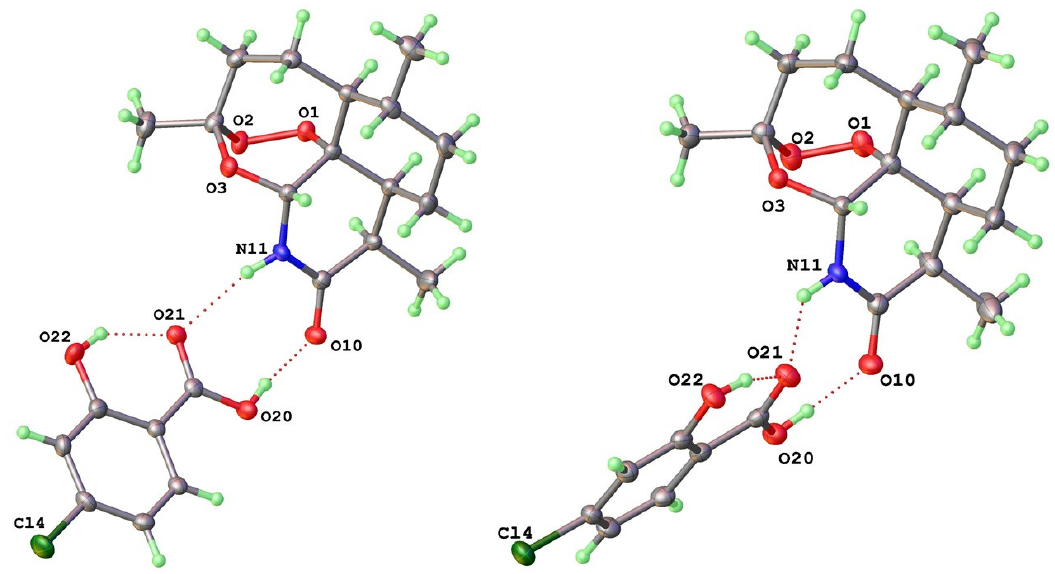
Figure 7. Variation in molecular pair conformations in crystal structure of 11-Aza:4-Cl-SalA, 2a (Type-I) and 2b (Type-II) (50% atomic displacement ellipsoids).